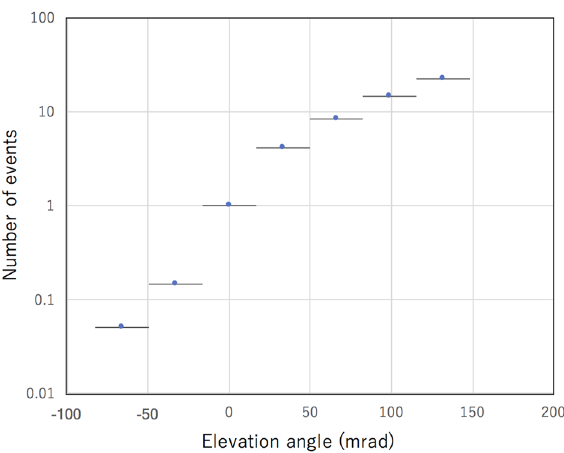
Figure 9. Fraction of the fake tracks generated by the scattered upward going muons as a function of elevation angle. Horizontal bars associated with data points indicate the angular region that occupies 75% of the total acceptance. The statistic errors are within the circles of the data